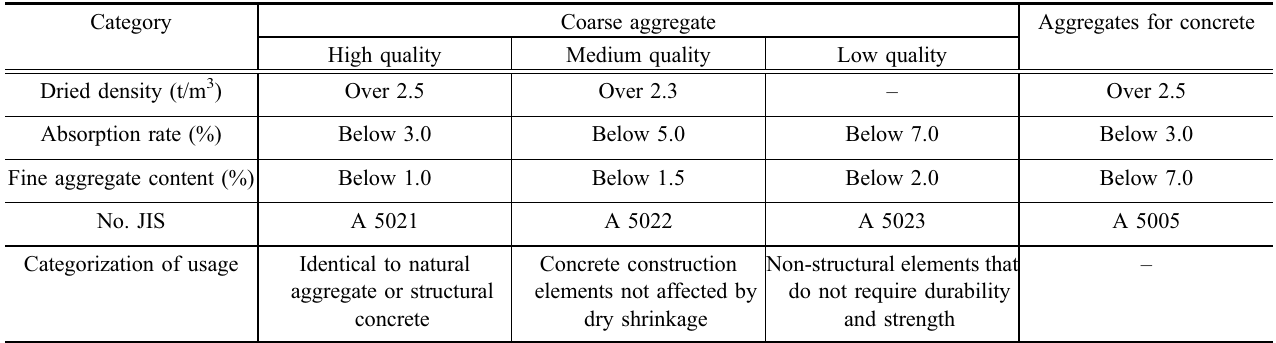
Table 2 Reference for categorizing concrete made with recycled coarse aggregate